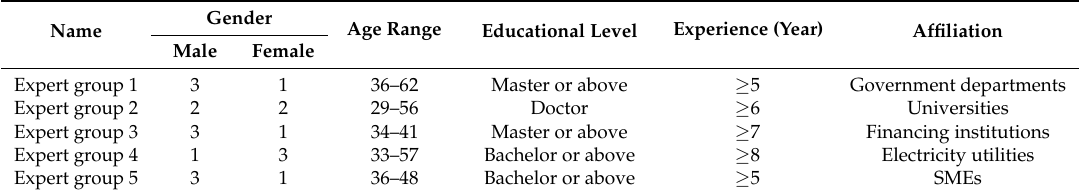
Table 3. The characteristics of the five expert